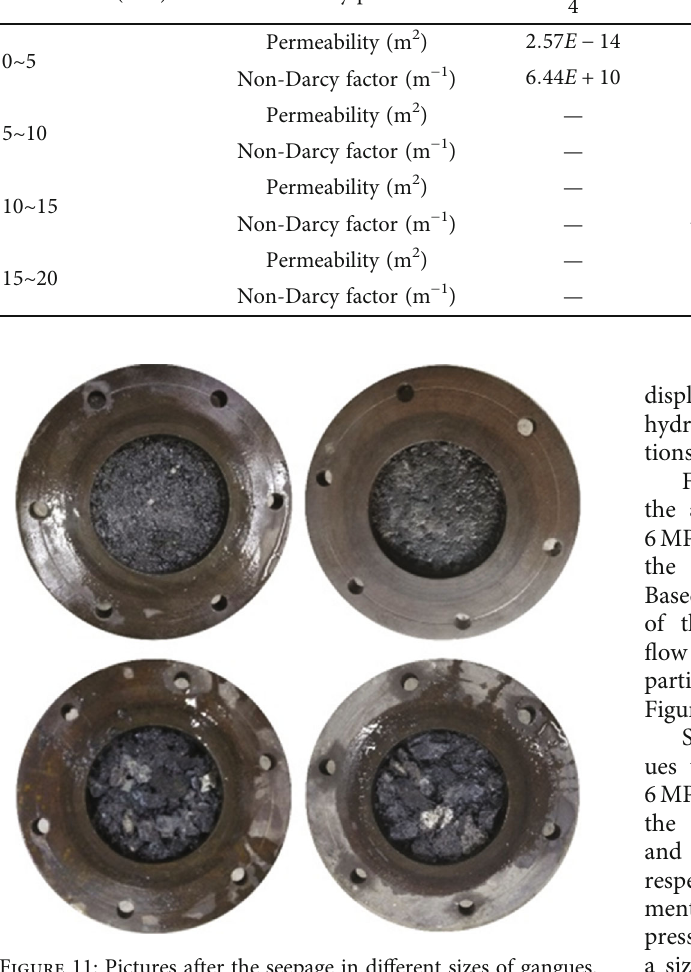
Figure 11: Pictures after the seepage in di ff erent sizes of